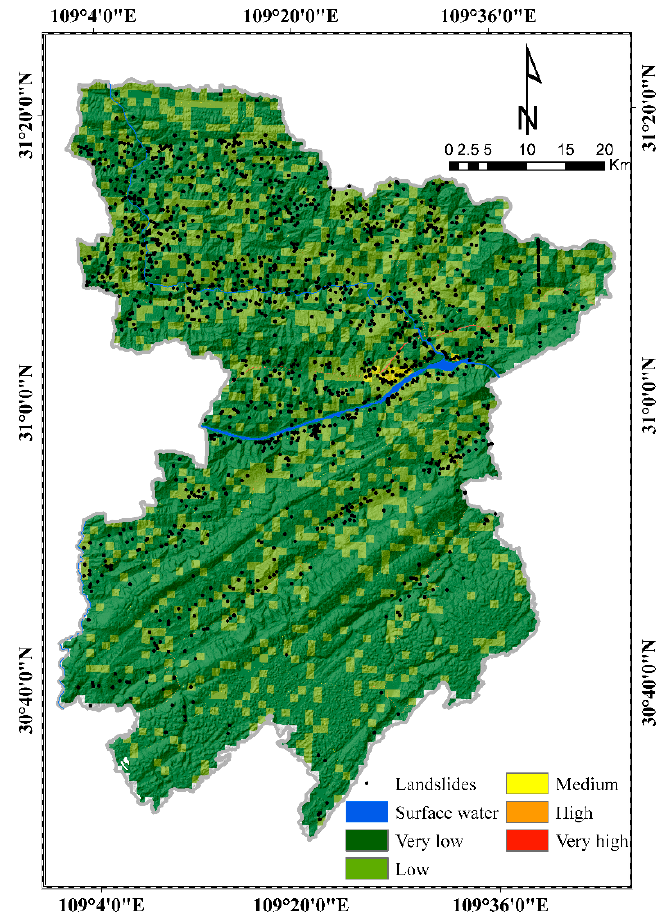
Figure 14. Landslide vulnerability Figure14. Landslide vulnerability map.